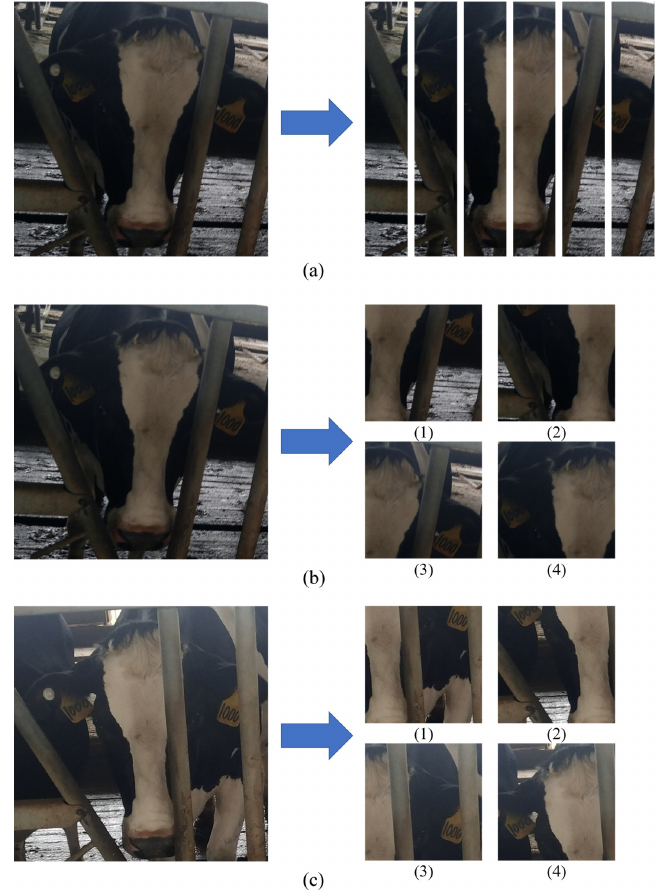
Figure 7. The extracted region visualization of the GPN and GPN-ST models. The left and right column of ( a ) separately represents the input image and the even partitions. The left and right columns of ( b , c ) separately represent the input images and the extracted the local regions with STN module.